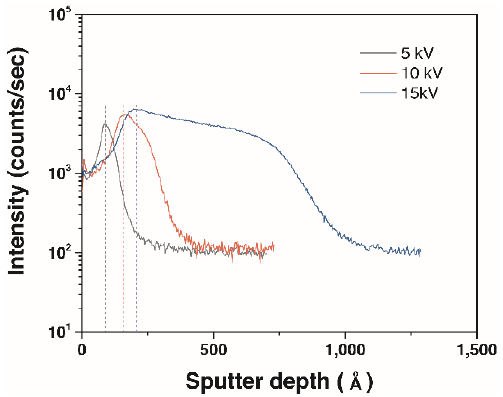
Figure 3. Secondary ion mass spectrometry (SIMS) depth profiles of nitrogen contents in the implanted samples at the different bias voltages. Table 3. Implanted ion range of TRIM simulations and SIMS analysis